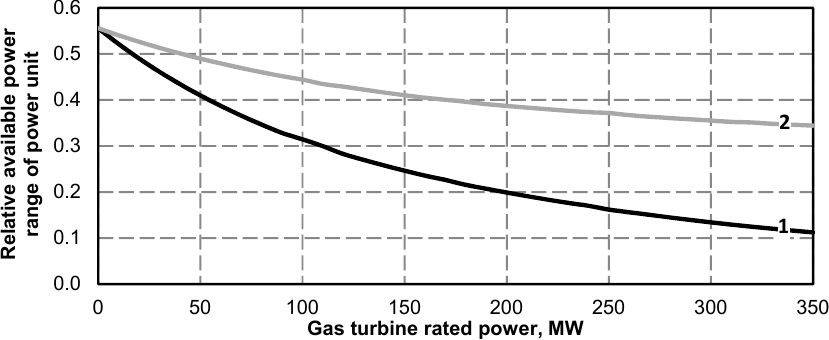
Figure 16. Relative available power range of power unit as a function of gas turbine rated power: 1 — gas turbine operating at its rated power, 2 — gas turbine operating with variable power ranging from 100% to 60% of its rated power.